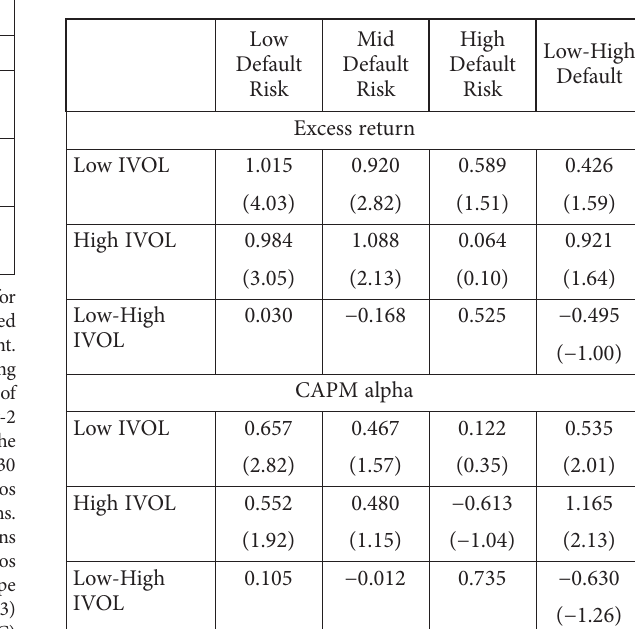
Table 6. Default risk premium and idiosyncratic